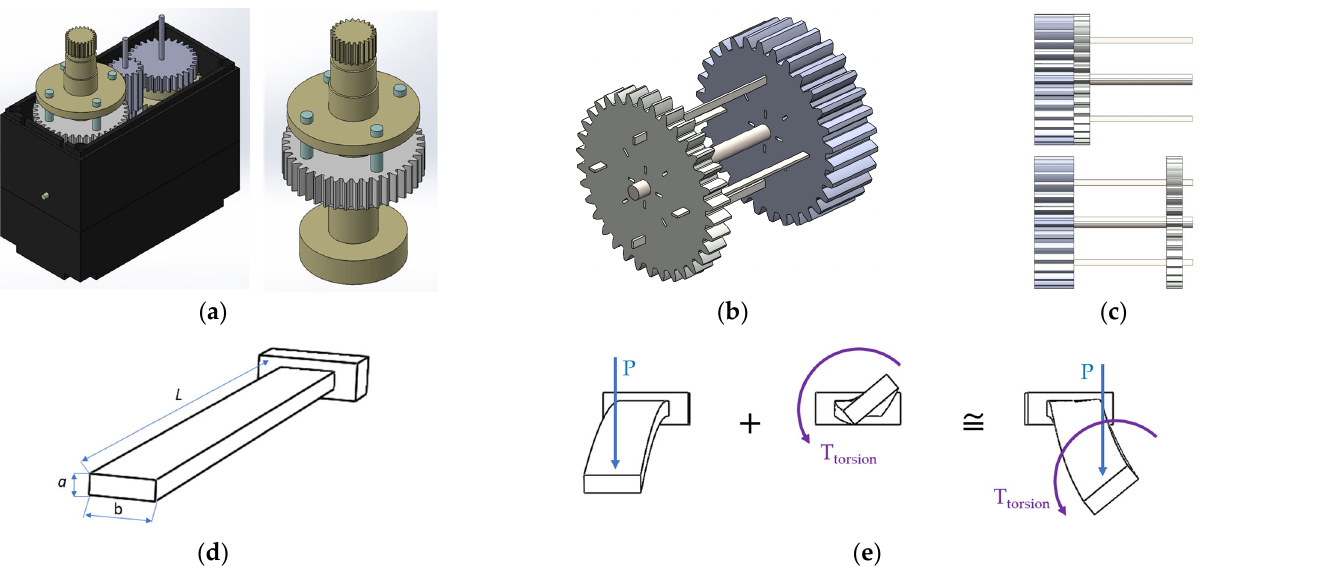
Figure 1. Basic structural elements of the adjustable stiffness clutch and loading conditions of beams. ( a ) The previous version of the stiffness-adjustable clutch mechanism with cylindrical cross-section beams [16], ( b ) solid model of the adjustable stiffness clutch mechanism, ( c ) rigid connection, (L = 0), Elastic connection, (L = max), ( d ) dimensions of prismatic elastic beams, a = 0.7 mm, b = 2.2 mm, L = ( 0 − 35 ) mm ( variation range of the active clutch length ) , and ( e ) sum of bending and torsion of prismatic (non ‐ circular) beam T = 4 T torsion + 4 T Bending